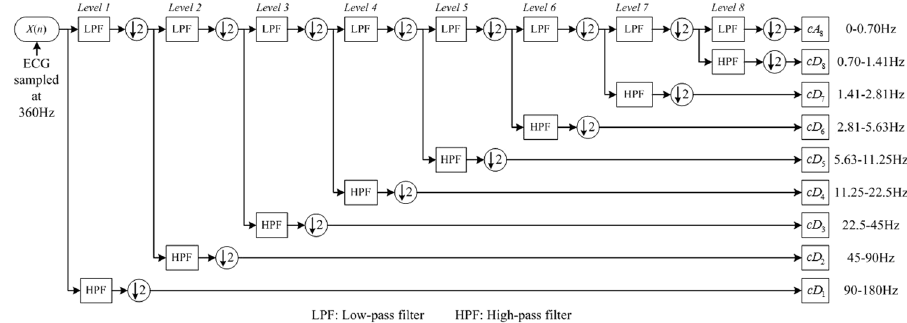
Figure 3. The decomposition process of the 8-level WMRA.